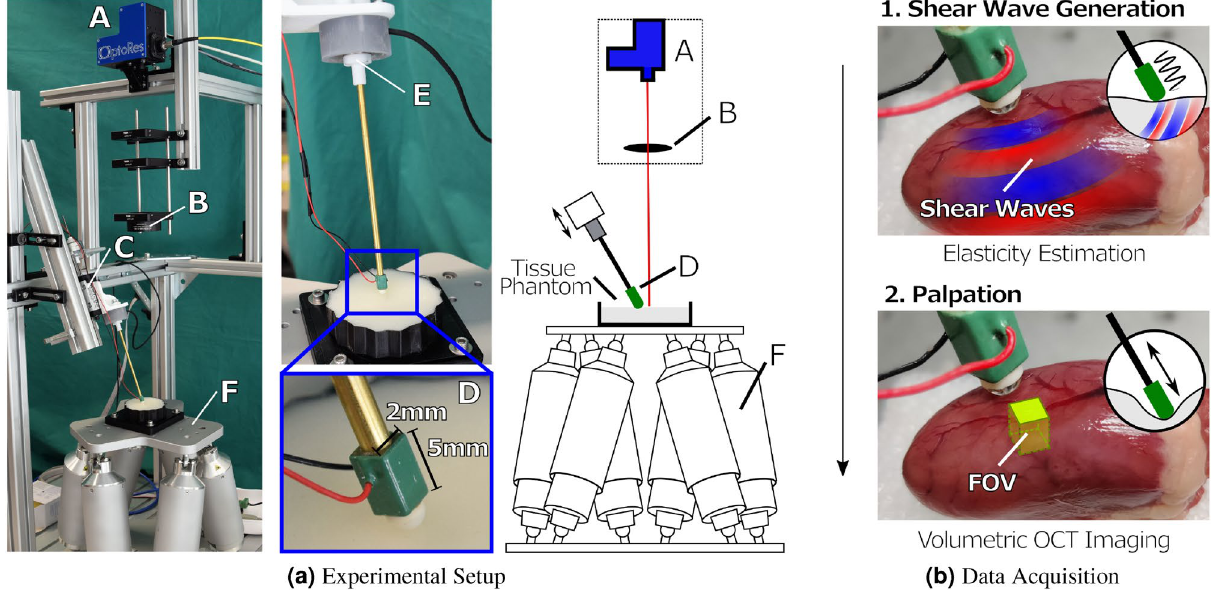
Figure 3. Experimental setup and data acquisition: (a) The experimental setup includes a high frequency scan head (A), a lense system (B), a stepper motor (C) which drives the palpation tool fitted with a piezoelectric element (D) along its central axis, a high resolution force sensor (E) for ground truth data annotation and a hexapod robot (F) for positioning the sample. Depicted is the setup with a gelatin phantom. (b) For data acquisition, we excite shear waves through vibration of the piezoelectric element (as indicated in red and blue) and OCE data is recorded. During tool-tissue interaction, we acquire volumetric image data as seen on the chicken